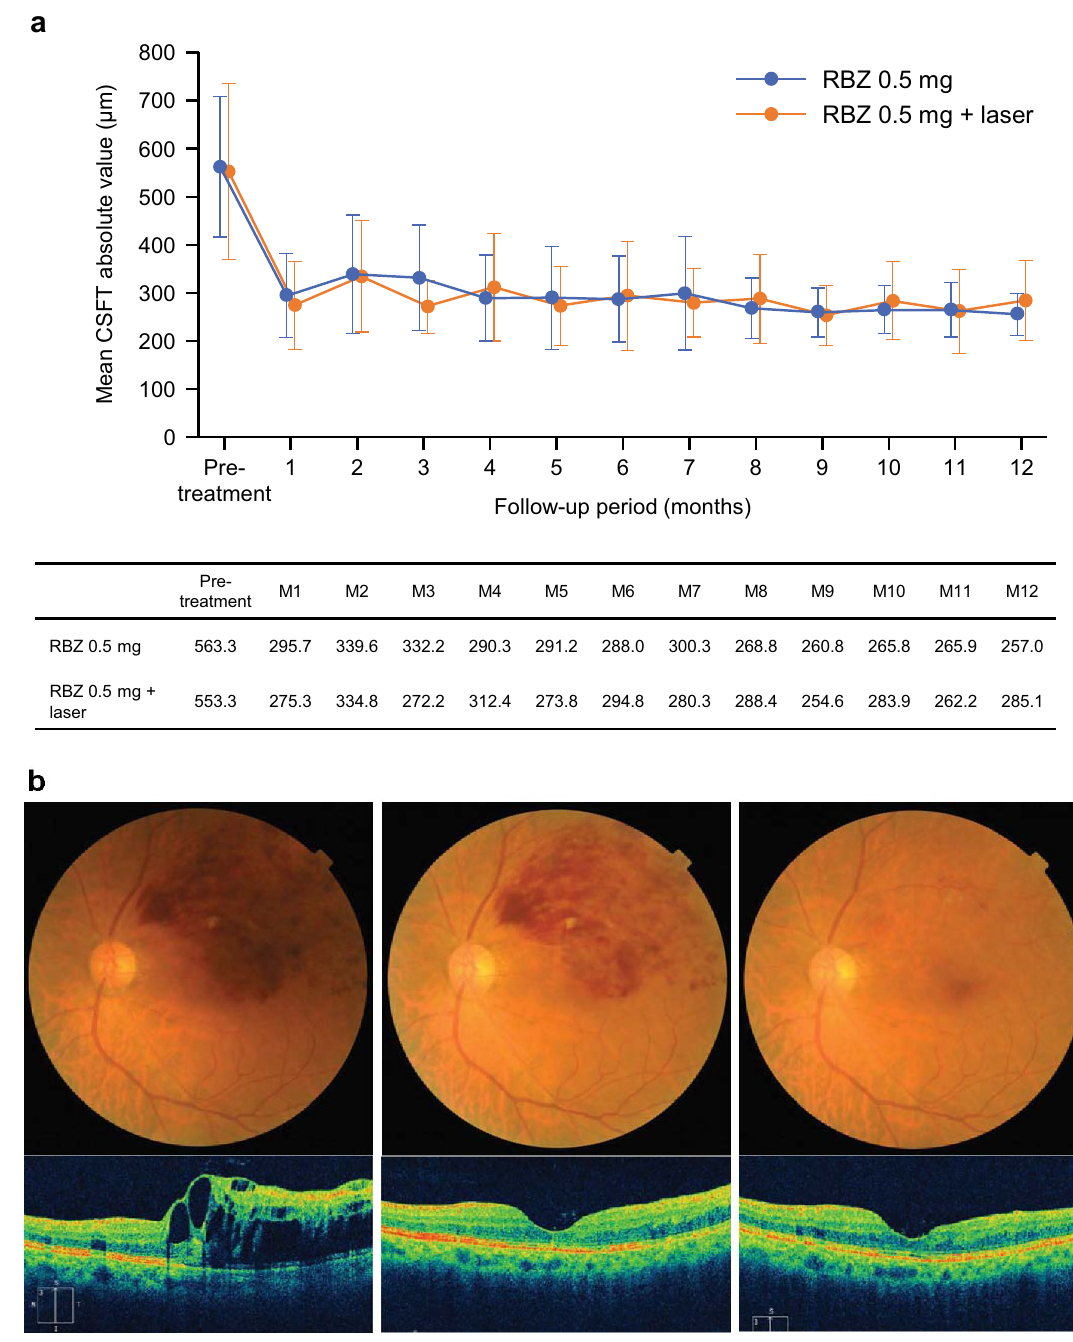
Figure 2. ( a ) Changes in central subfield foveal thickness (CSFT) absolute values over time in all patients. ( b ) A representative case that showed drastic reduction of CSFT and visual acuity (VA) improvement at Month 1, which were maintained up to Month 12 by 1 + PRN ranibizumab injection. In Fig. 1b: Left panel: Baseline fundus photograph and optical coherence tomography (OCT). Hemorrhage is present in the upper half of the macula. OCT shows prominent macular edema (ME). CSFT was 642 μm. VA was 20/50. Middle panel: Month 1. Macular hemorrhage is still present, but OCT shows marked reduction of ME. CSFT was 228 μm. VA was 20/28. Right panel: Month 12. Macular hemorrhage completely resolved. CSFT was 234 μm and OCT showed a well-preserved ellipsoid zone in the fovea. VA was 20/17 (88 ETDRS letters). RBZ